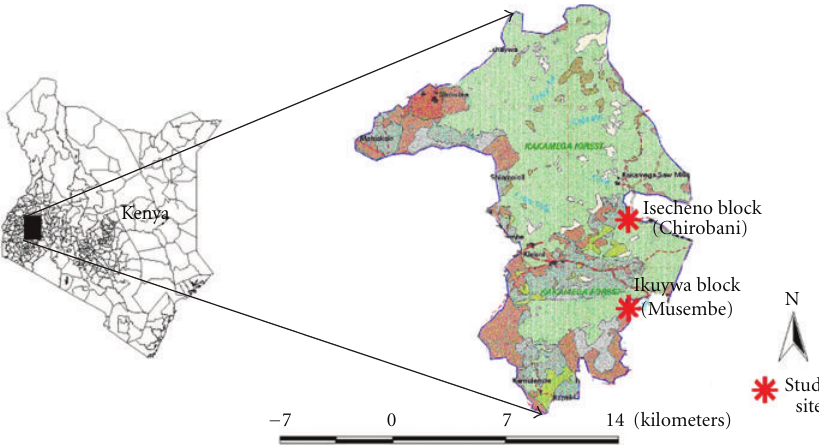
Figure 1: Study sites in the Kakamega Forest of Western